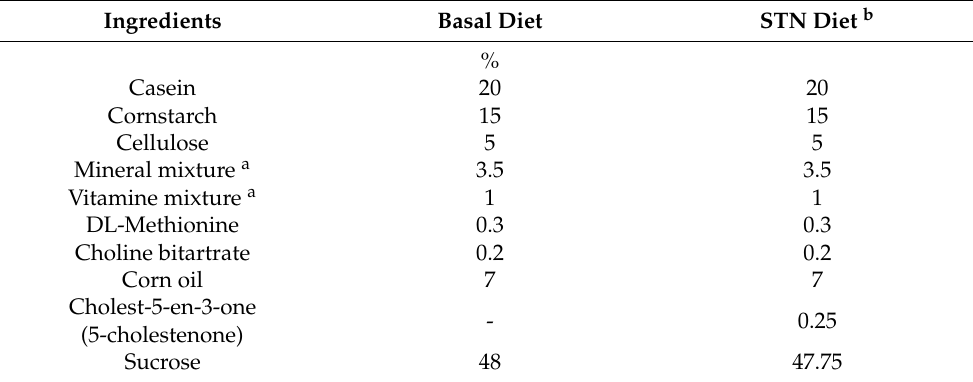
Table 1. Composition of experimental